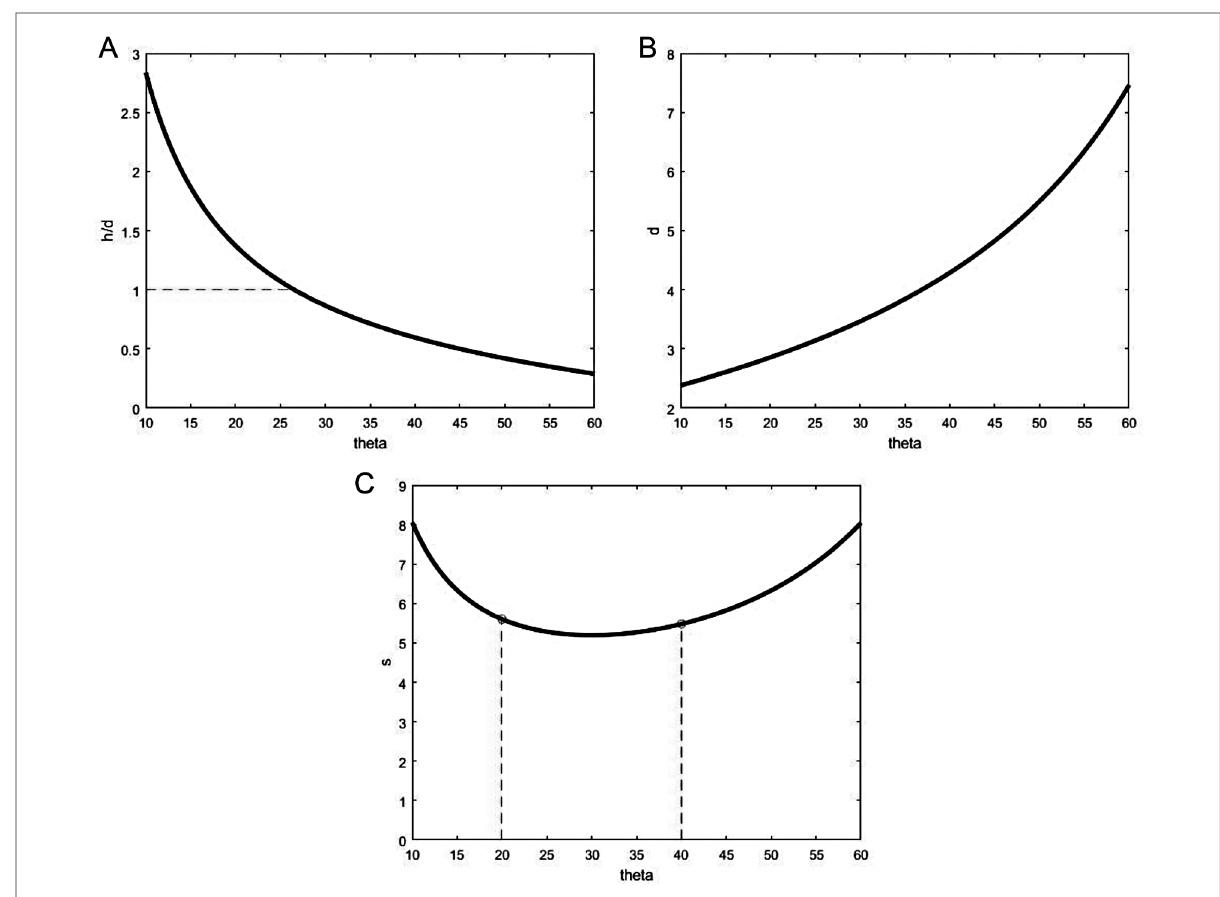
FIGURE 8 Relationship of A-T fl ap geometry and half apex angle. ( A ) Ratio h/d vs. ∠ θ . ( B ) Maximum suture distance d vs. ∠ θ . ( C ) Area S vs. ∠ θ